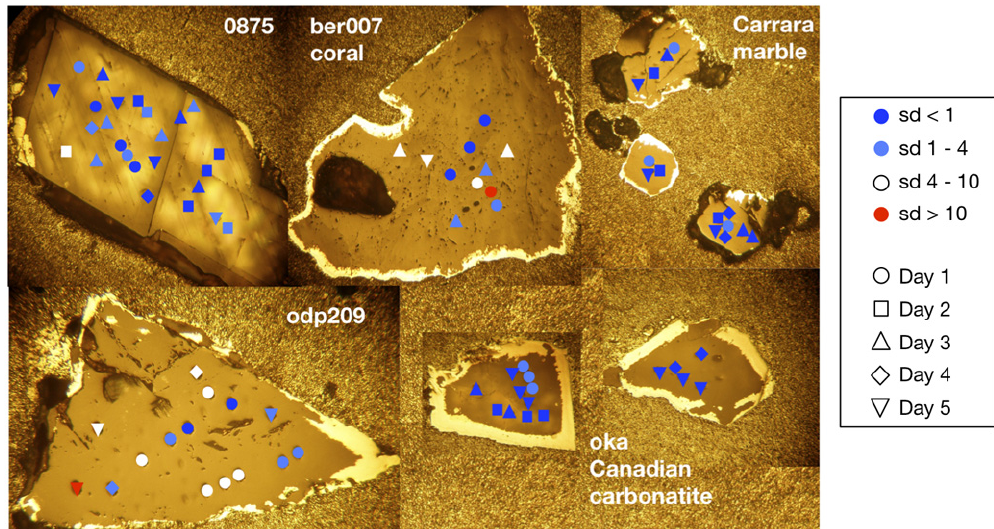
Fig. 3. Standard heterogeneity index. Point color represents the standard deviation between the B concentration (ppm) of the point measured on that day and converted using that day’s calibration curve and the absolute value of the standard. Standard deviation (sd) < 1 is represented by dark blue, sd 1–4 by light blue, sd 4–10 by white, and sd ≥ 10 by red (i.e. high proportion of blue points indicates a good quality standard with low heterogeneity). The shape of the point refers to the measurement day: Day 1, circle; Day 2, square; Day 3, triangle point up; Day 4, diamond; and Day 5, triangle point